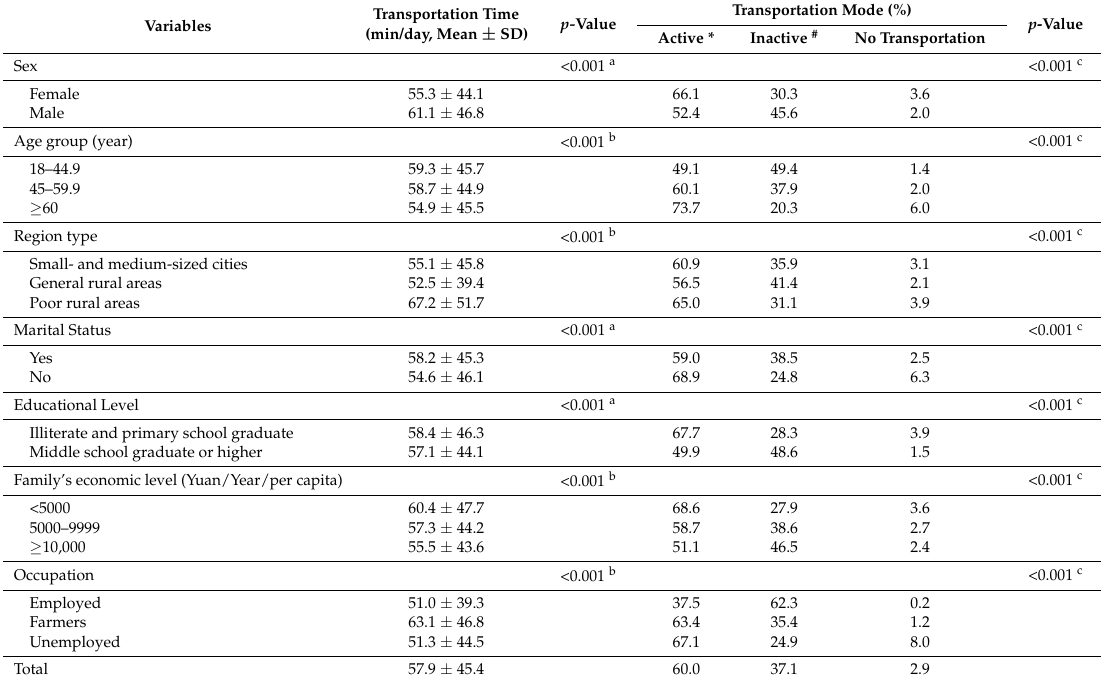
Table 4. Transportation time and mode stratified by social